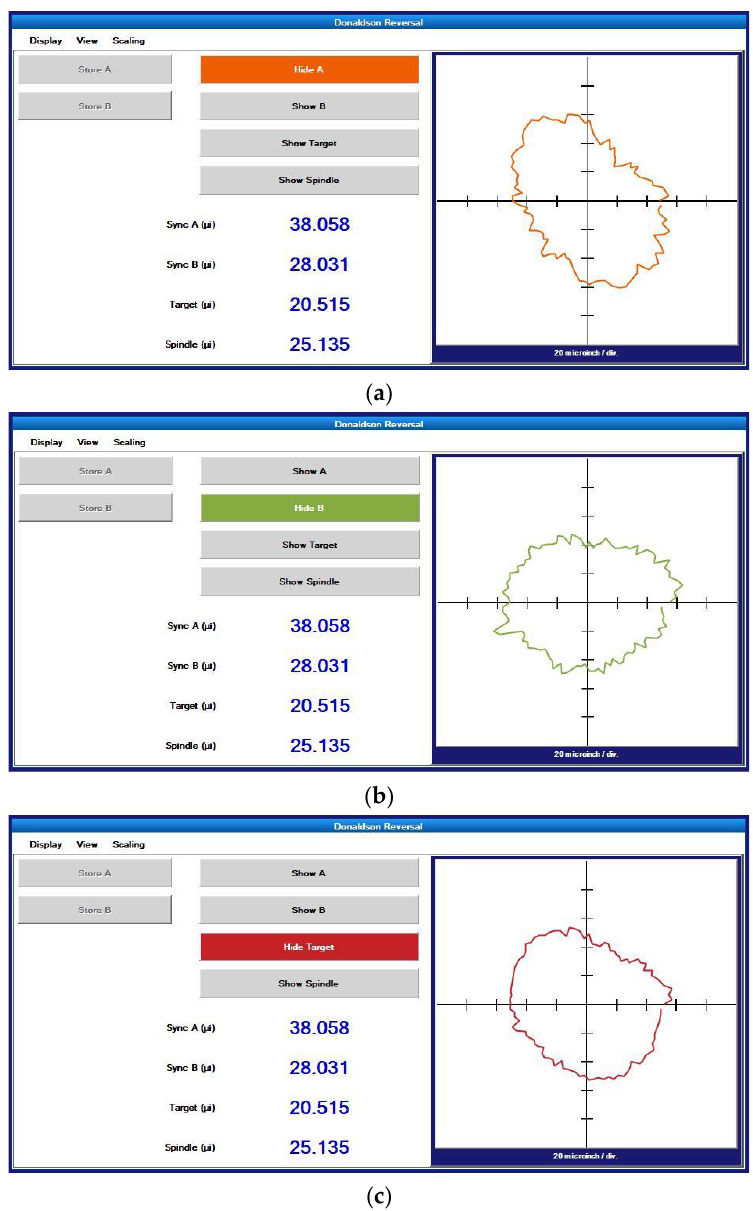
Figure 10. Donaldson reversal method measurement device: ( a ) before reversal, ( b ) after reversal.